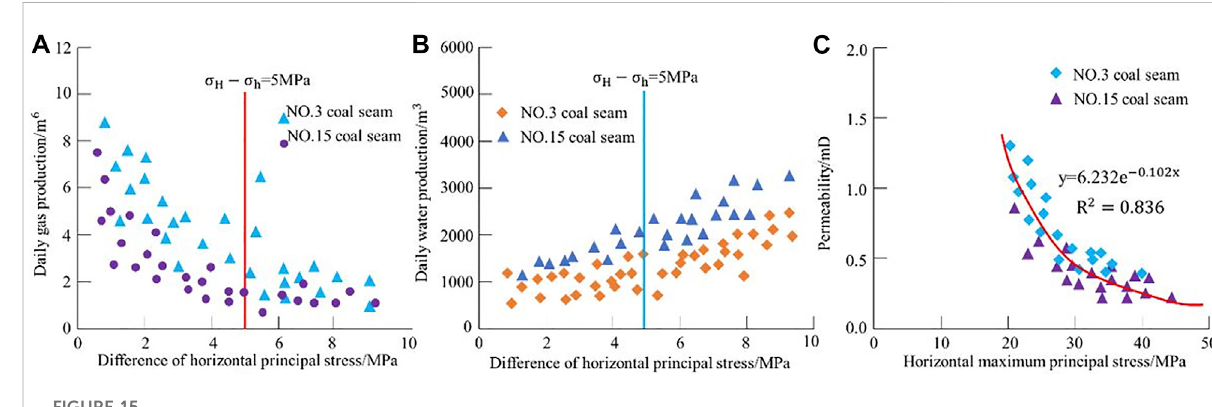
FIGURE 15 Relationship between the horizontal principal stress and daily gas volume, daily water volume, and